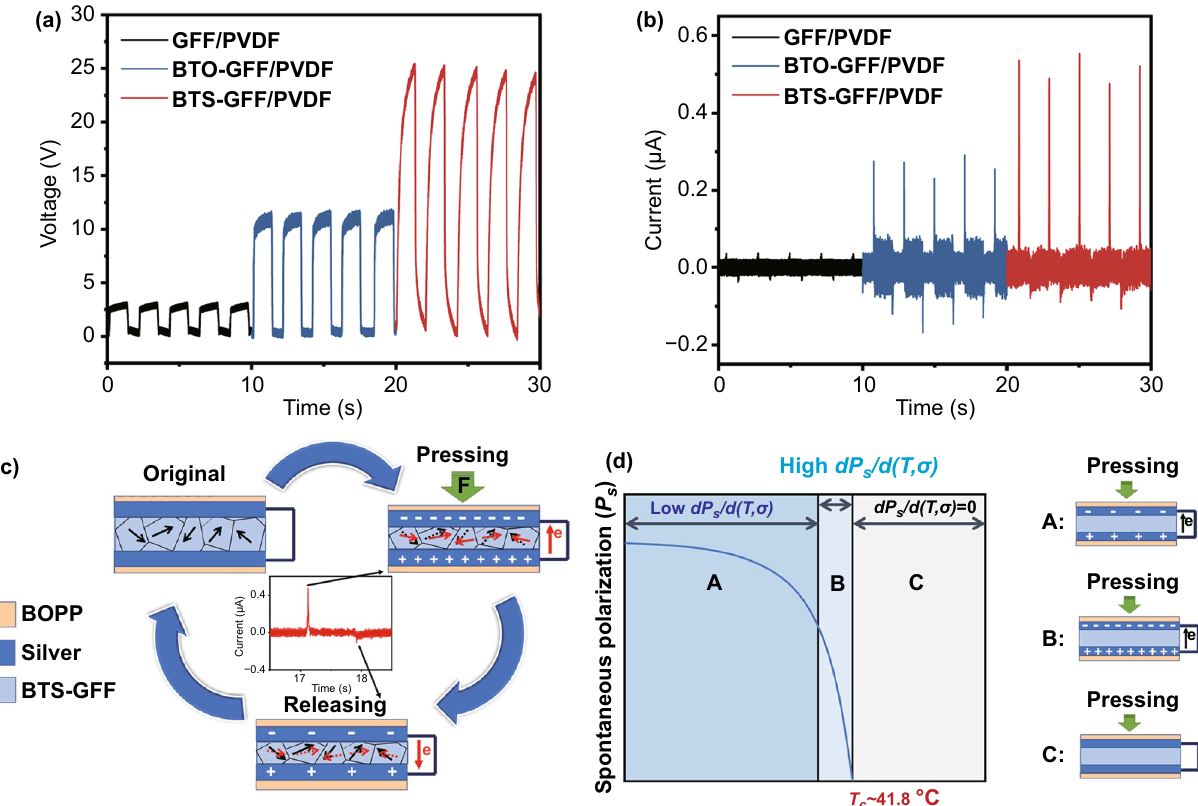
Fig. 3 a, b Output of GFF/PVDF sensors, BTO-GFF/PVDF sensors, and BTS-GFF/PVDF sensors under the applied force of 40 N, 0.5 Hz. c Working mechanism of BTS-GFF/PVDF sensors. d Effect of T c on polarization [39] and electric responses of sensors under different working